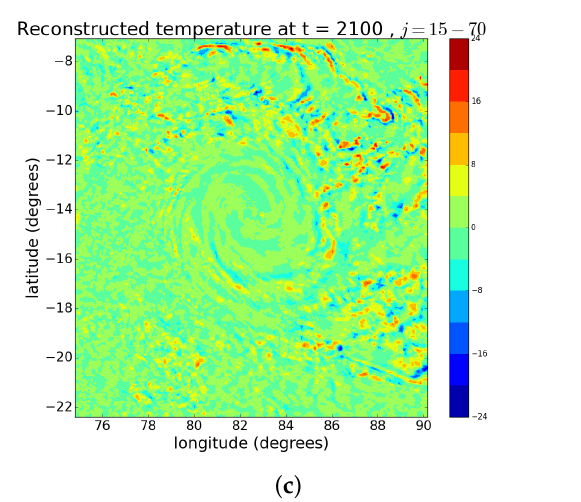
Figure 7. Temperature field reconstructions at 21.00 UTC on 8 February 2021, for Faraji cyclone, ( a ) macroscale, ( b ) mesoscale, and ( c )